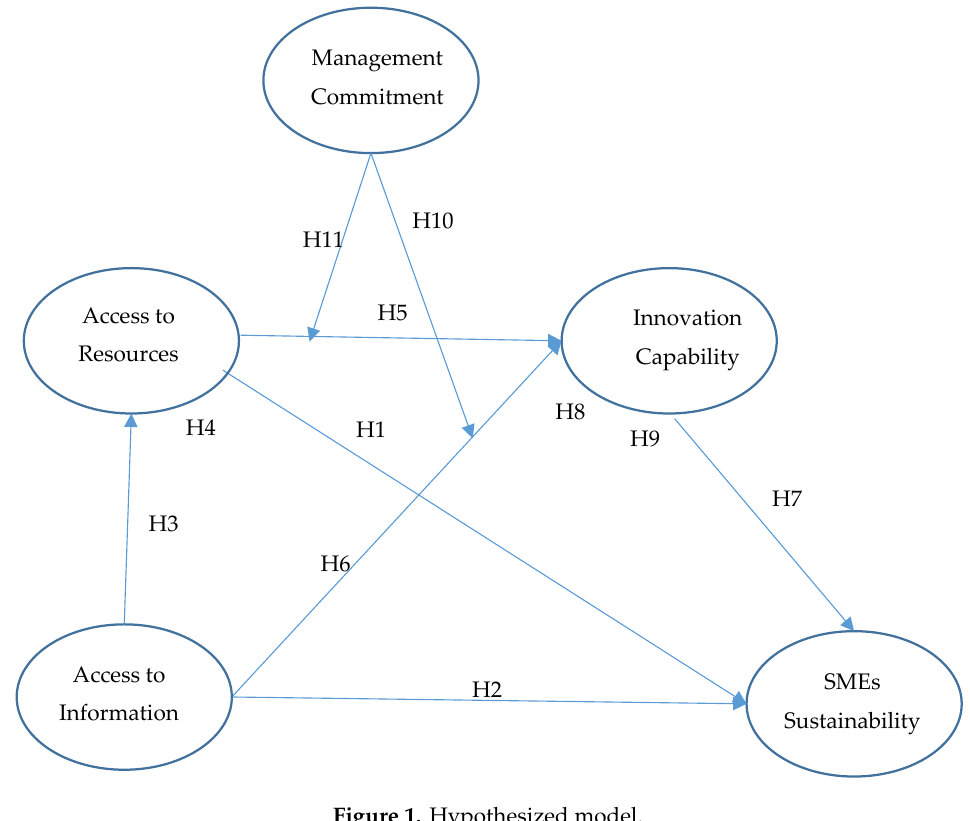
Figure 1. Hypothesized model.